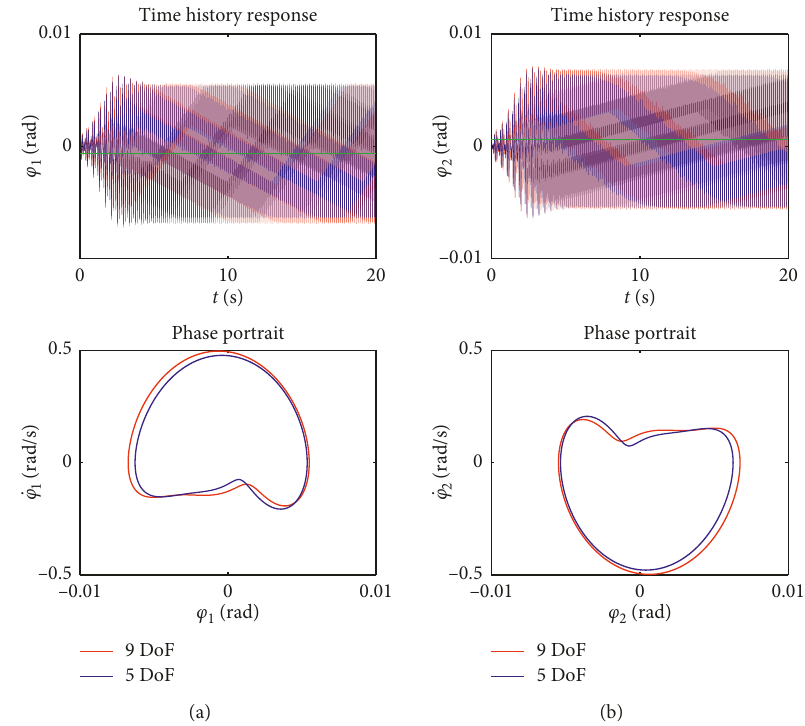
Figure 5: Dynamic responses of front wheel axes’ lateral swing. (a) Front-left wheel axis. (b) Front-right wheel